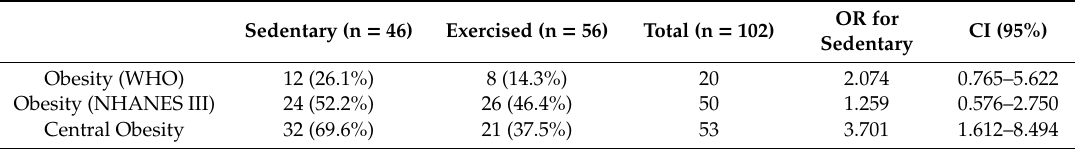
Table 3. Modes of obesity between sedentary and exercised